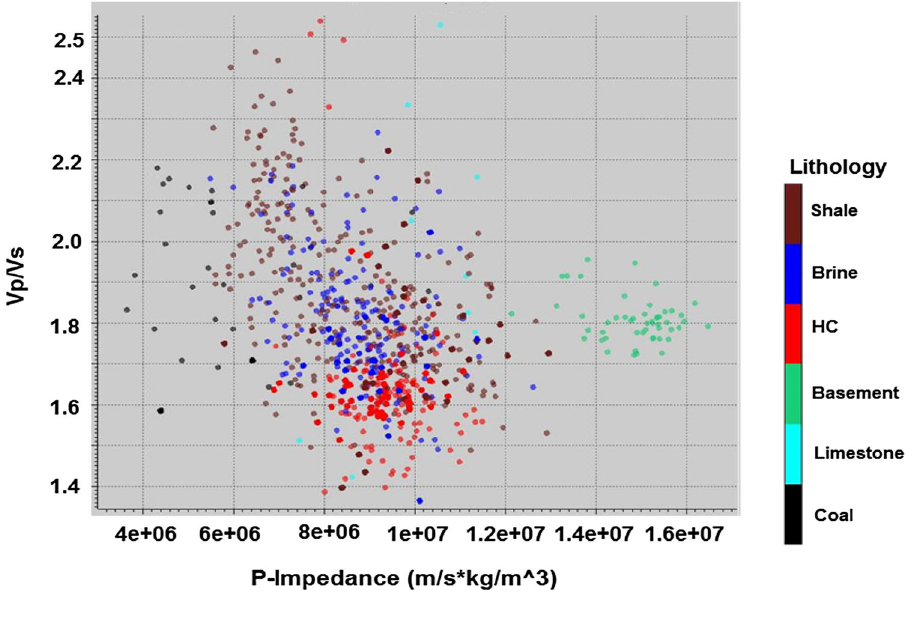
Fig. 19 Measured P-impedance versus modeled V P / V S for all wells colored by